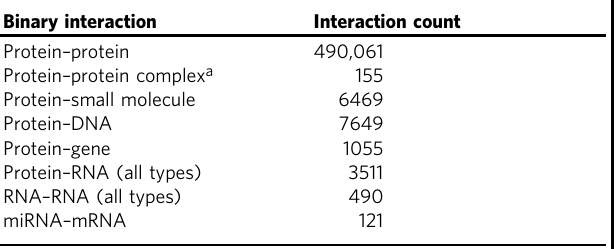
Table 2 Number of binary molecular interactions for different interactor types present in the IMEx dataset, May 2020 (human – human data only).